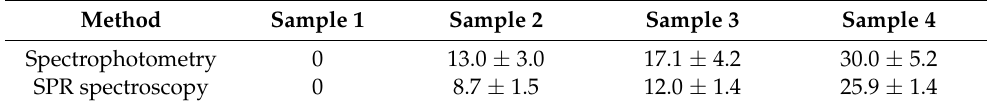
Table 1. Measured thickness values in nm for the dielectric